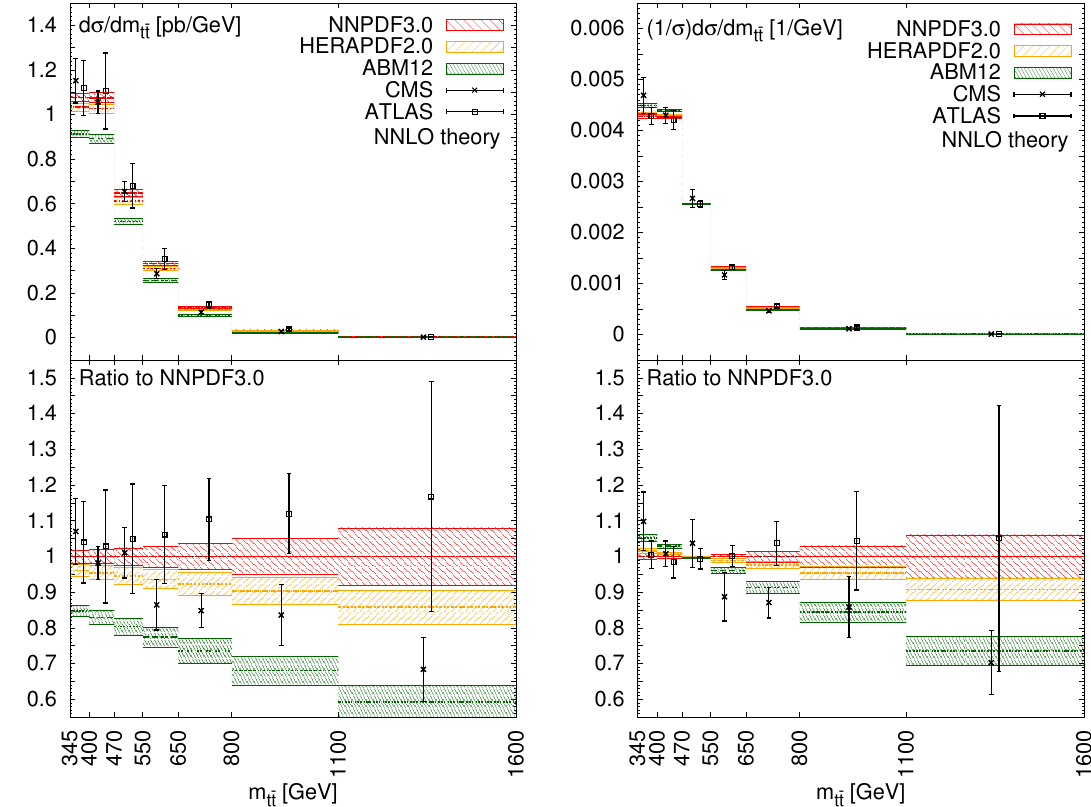
Figure 12 . Same as (cid:12)gure 11, now for NNPDF3.0, ABM12 and